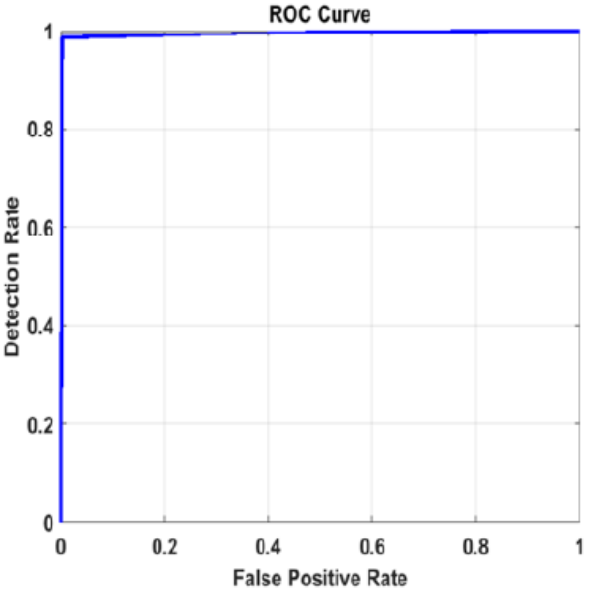
Figure 14. ROC curve for InceptionResNetv2 model with image SR using dataset